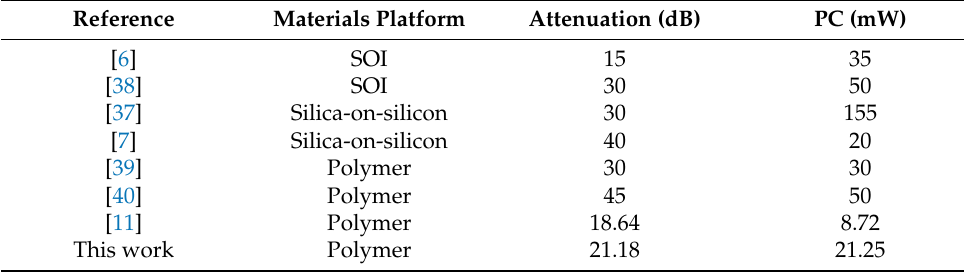
Table 1. Comparison of the VOA on different